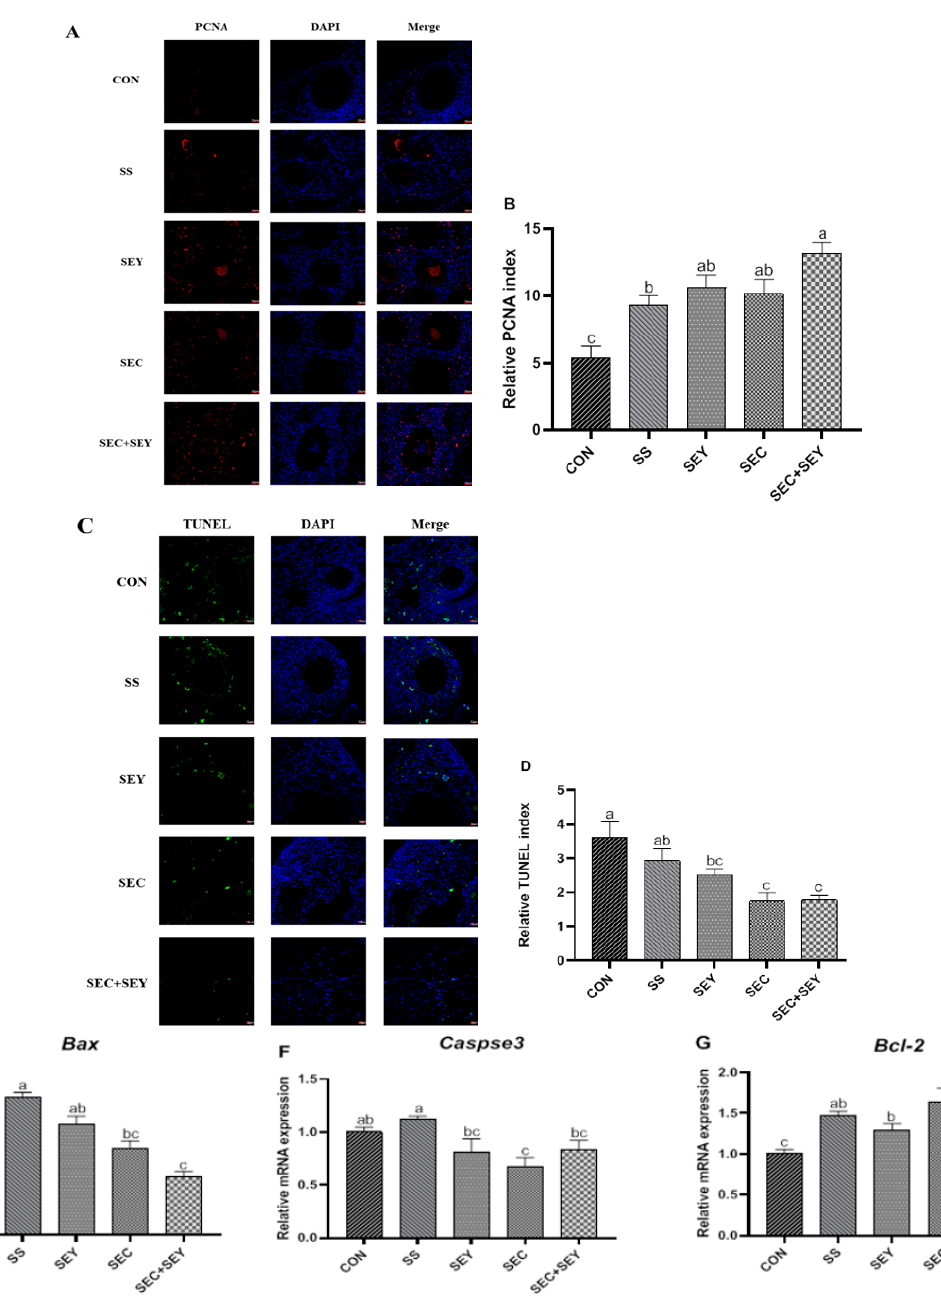
Figure 2. Effects of different Se sources on cell proliferation and apoptosis of ovaries in laying hens. ( A ): PCNA staining of the ovaries. ( B ): Quantification of PCNA-positive cells. ( C ): TUNEL staining of the ovaries. ( D ): Quantification of TUNEL-positive cells. All cell nuclei showed blue fluorescence, indicating DAPI staining. The PCNA-labeled cells exhibited red fluorescence, showing the prolifer- ative cells. The TUNEL-labeled cells exhibited green fluorescence, showing apoptosis. Scale bar = 10 μ m. ( E – G ): Effects of different Se sources on the expression of apoptosis-related genes in the ovary of laying hens. Data are means of 6 replicates per dietary treatment. Bars with different letters (a–c) indicate a significant difference ( p < 0.05). Bax, BCL2-associated X; Bcl-2, B-cell lymphoma-2.